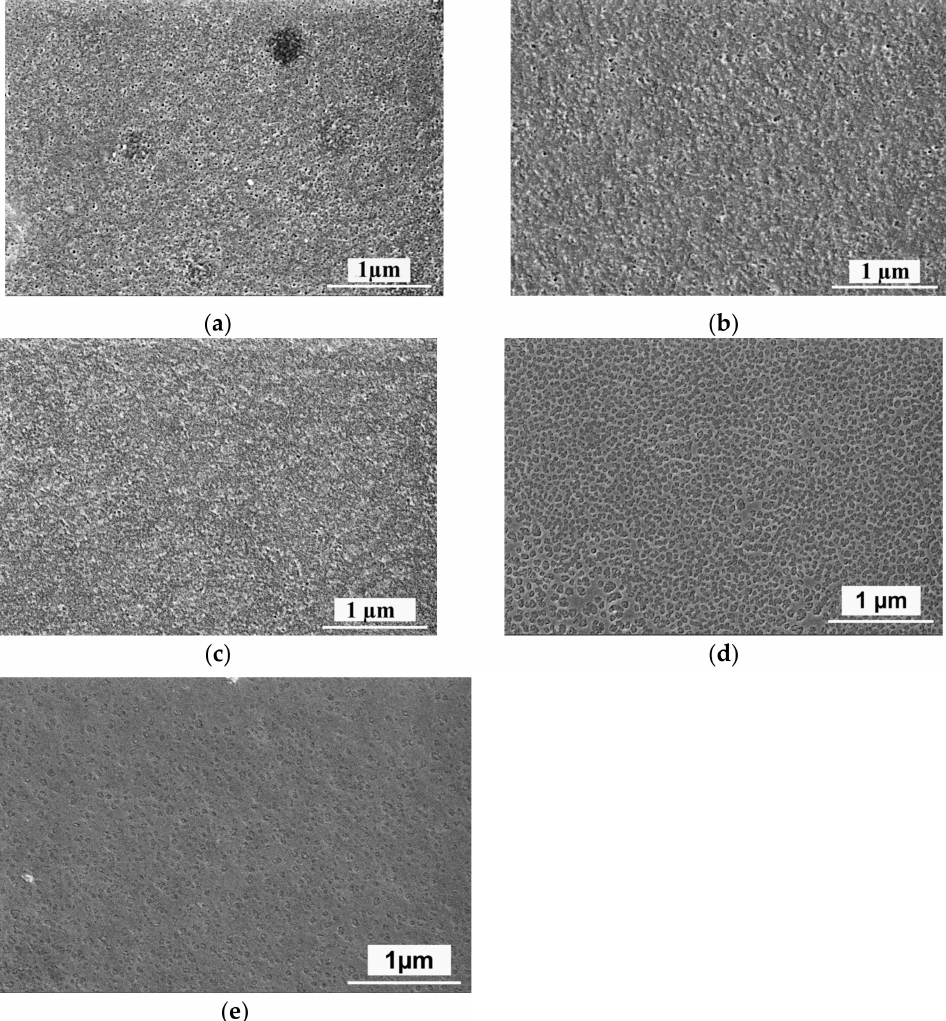
Figure 5. SEM microphotographs of the membrane selective layer surface: ( a )—SA-0; ( b )—SA-0.35; ( c )—SA-0.7; ( d )—SA-1.0; ( e )—SA-2.0. Membrane samples were prepared by